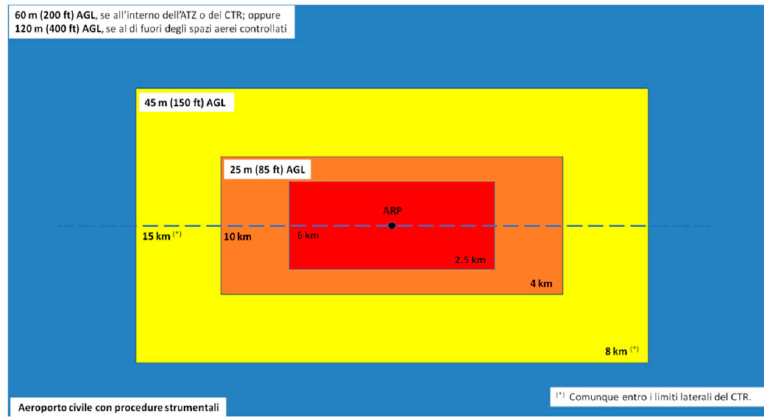
Figure 8. Maximum UAV flight height for a civil airport with instrumental procedures (ATM09 Note).